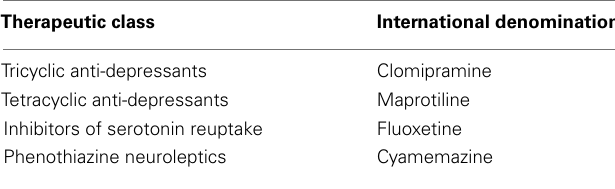
Table 1 | Psychotropic drugs contra-indicated in patients with Brugada syndrome (Antzelevitch et al., 2005).